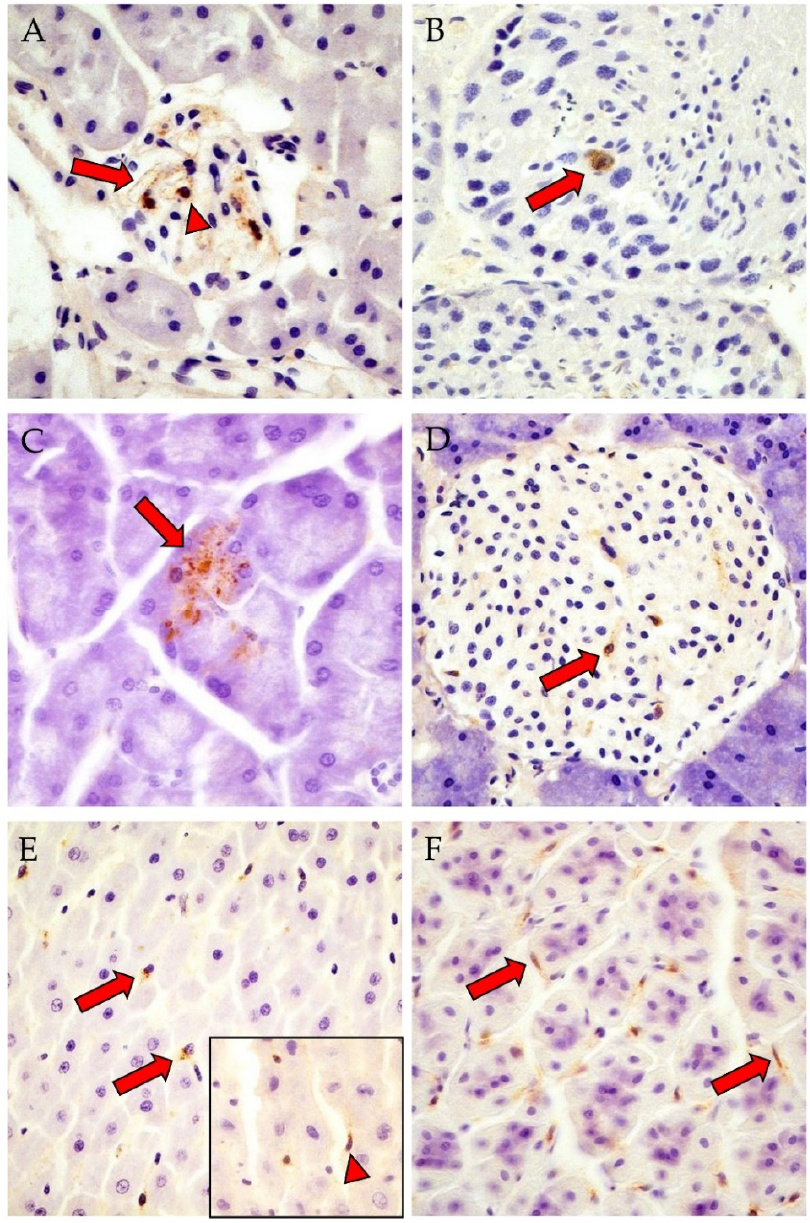
Figure 1. Detection of PUUV nucleocapsid (N) protein in different tissues of OS ( A , B , D , E , inset) and BF ( C , F ) bank voles by IHC. ( A ): male, RNA-positive, antibody-negative, kidney: positive endothelial cells (red arrow) and glomerulum cells (red arrowhead); ( B ): male, RNA-positive, antibody-positive, testis: sperm precursor cell with viral antigen (red arrow); ( C ): female, RNA- positive, antibody-positive, exocrine pancreas: positive acini (red arrow); ( D ): male, RNA-positive, antibody-positive, endocrine pancreas: positive islet cells of Langerhans (red arrow); ( E ): male, RNA-positive, antibody-negative, liver: positive Kupffer cells (red arrows); inset: female, RNA- positive, antibody-negative, N protein in cells with elongated spindle-shaped nuclei at sinusoid periphery (red arrowhead); ( F ): female, RNA-positive, antibody-positive, pars glandularis of the stomach: viral antigen in interstitial cells with lancet to spindle-shaped nuclei (red arrows). Total magnification: 400×. Corresponding positive signals in OS or BF voles are shown in Figure S5. IHC images of kidney, pancreas, liver and pars glandularis of the stomach of the negative control vole are shown in Figure S4.